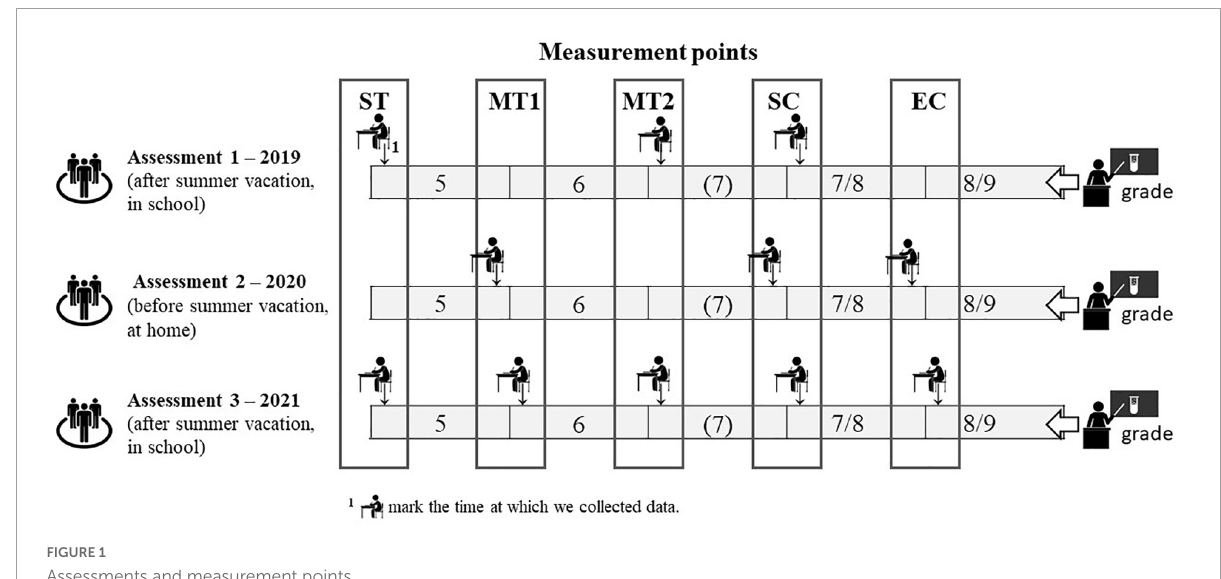
FIGURE1 Assessments and measurement